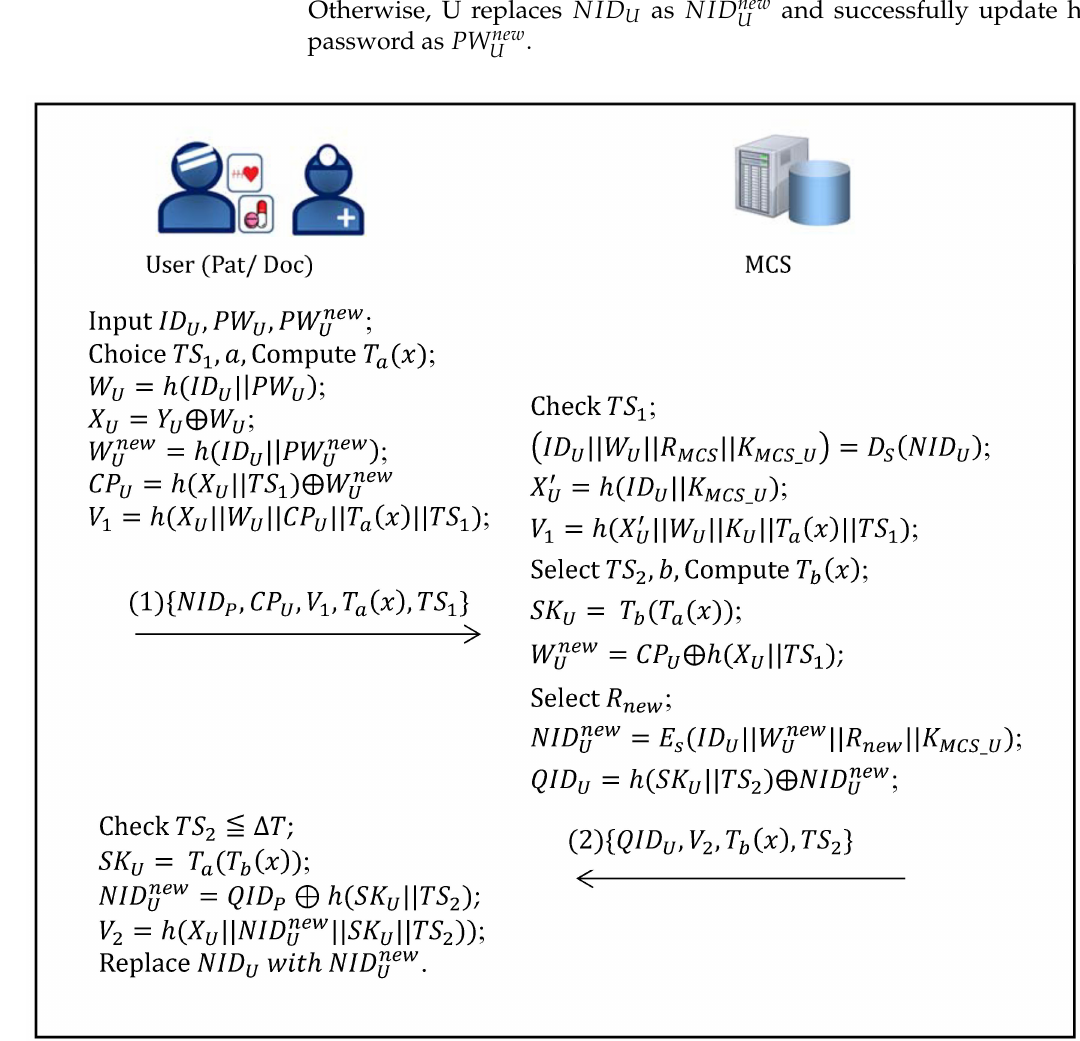
Figure 4. The processes of the password update phase of the proposed